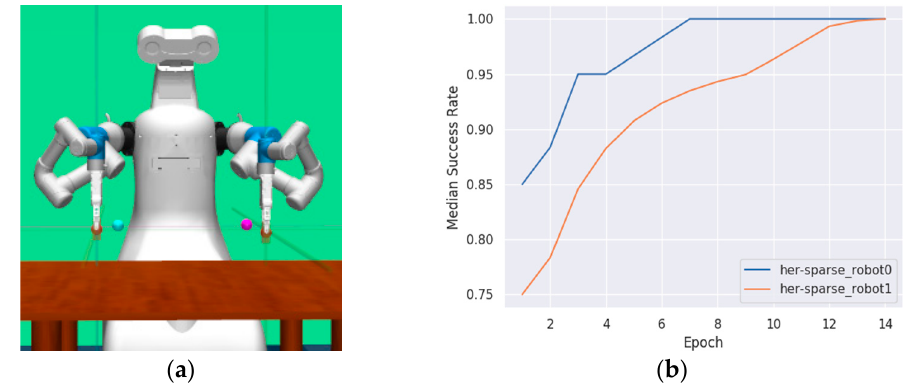
Figure 2. Reach scene. ( a ) The left and right target positions are randomly chosen in 3D space. Control the left and right end effectors of the robot to reach the left and right targets as quickly as possible. ( b ) The learning curve of Reach scene—the abscissa is the number of training rounds and the ordinate is the average success rate of 10 tests.